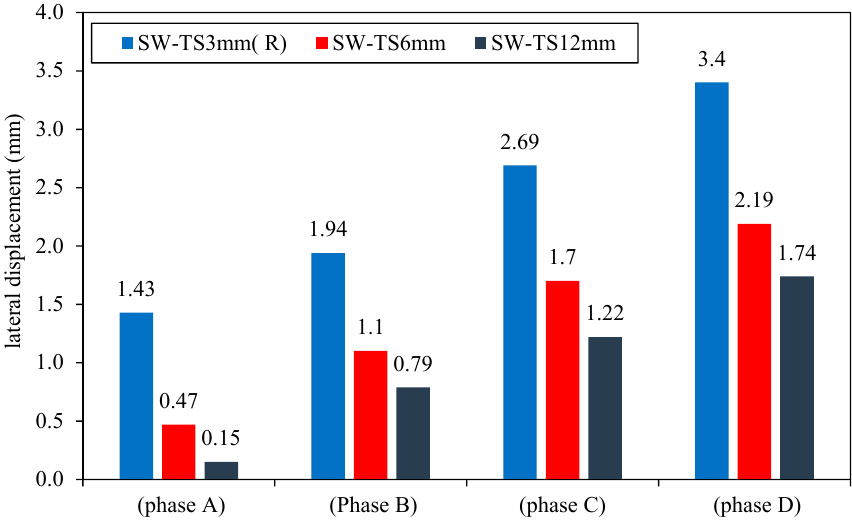
Figure 14. Lateral displacement of group 2.